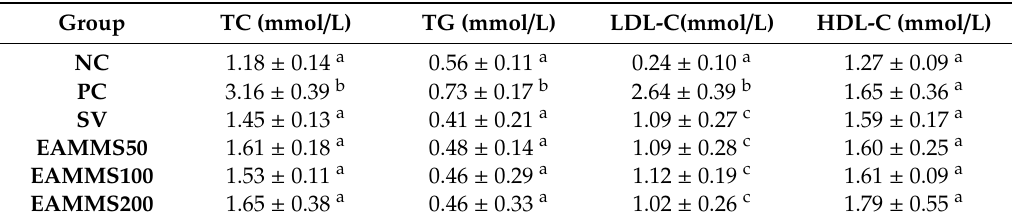
Table 3. Serum lipid profiles of hypercholesterolemia-induced rats treated with di ff erent concentrations of Mikania micrantha stems (EAMMS) extracts at week